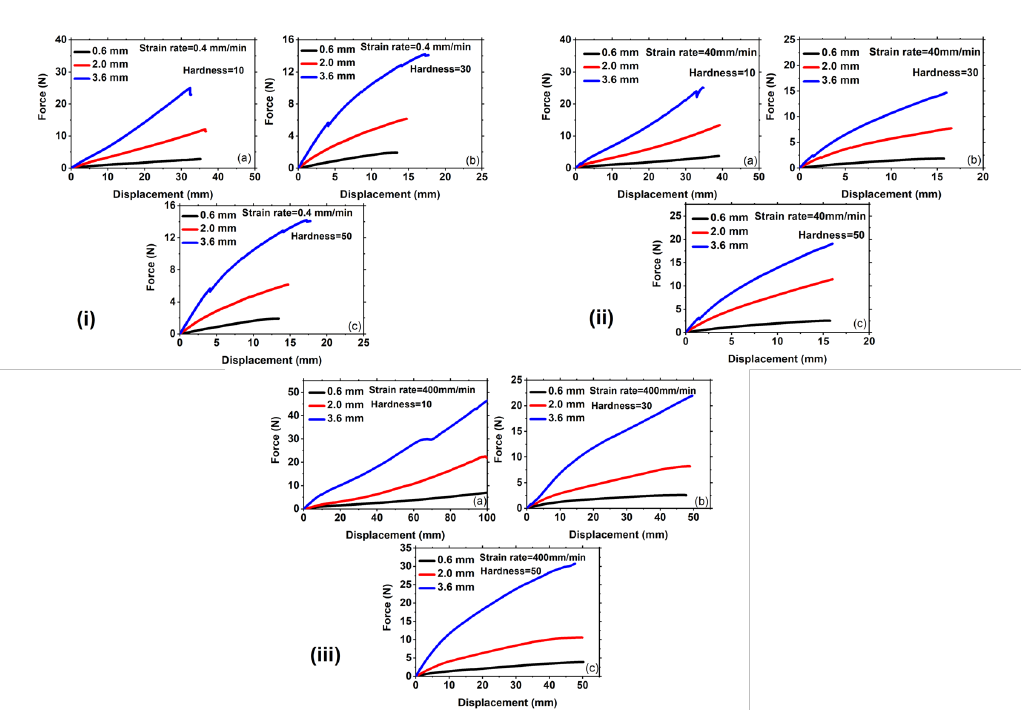
Figure 7. Representation of force versus displacement curves of the specimen under pure shear loading at a strain rate of ( i ) 0.4 mm/min for different hardness of ( a ) 10; ( b ) 30; and ( c ) 50, respectively, ( ii ) 40 mm/min for different thicknesses of ( a ) 10; ( b ) 30; and ( c ) 50, respectively, ( iii ) 400 mm/min for different thicknesses of ( a ) 10; ( b ) 30; and ( c ) 50, respectively. Note: the scales of the figures are